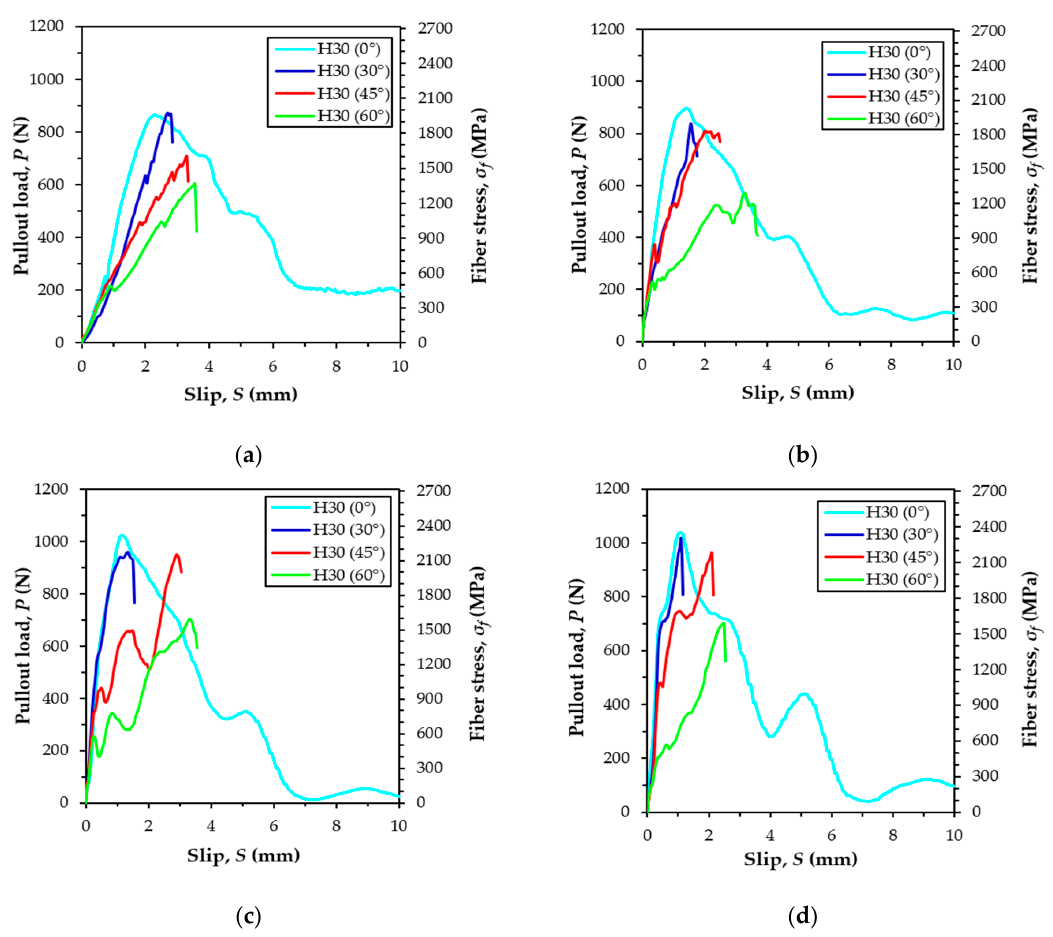
Figure 9. Average pullout load versus slip curves on H-fibers at various loading rates: ( a ) quasi-static, ( b ) air pressure of 2 kN, ( c ) air pressure of 5 kN, and ( d ) air pressure of 8 kN.